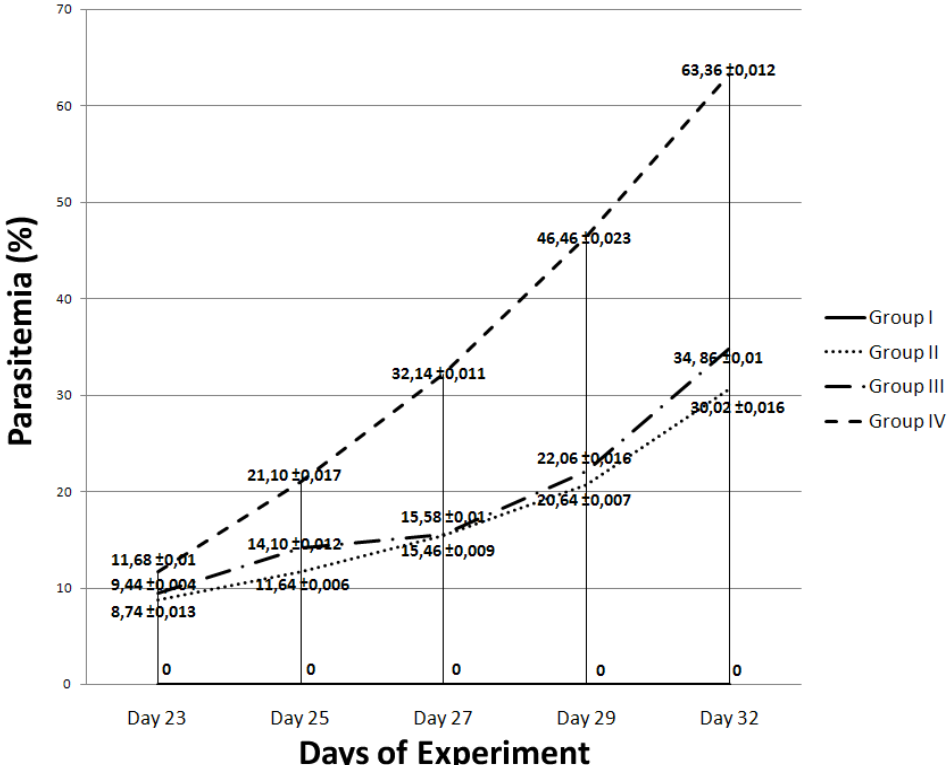
FIGURE 1 - Parasitemia’s curve of the different groups during the